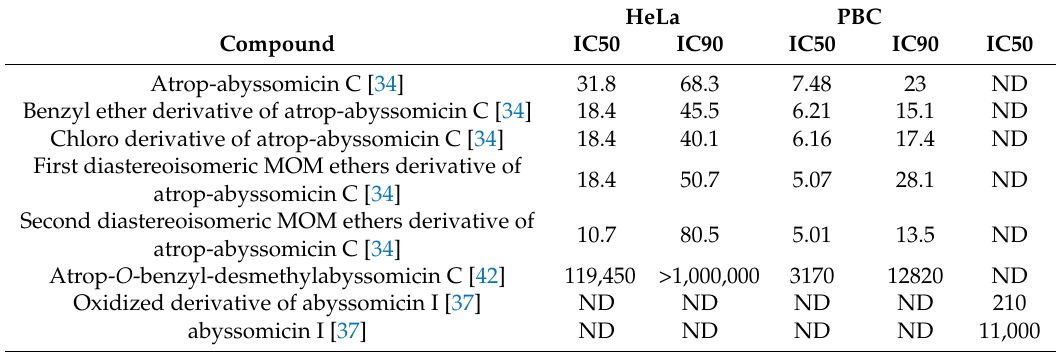
Table 3. Cytotoxicities of selected abyssomicin